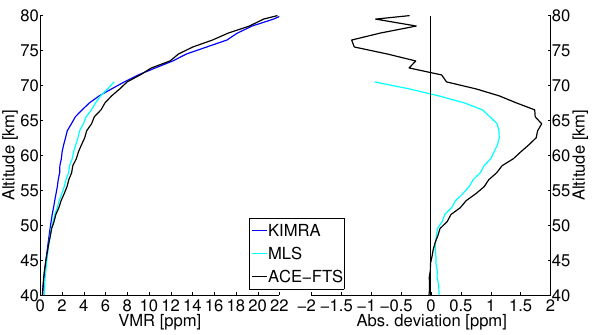
Fig. 16. Comparison of KIMRA with MIPAS (MA mode) and MLS using the collocation criteria R =1000km and 1 PV=20%. 9 days with coincidences were found. Left panel: mean profiles derived according to Sect. 5.1. Right panel: deviation between the KIMRA and the satellite profiles calculated with Eq.